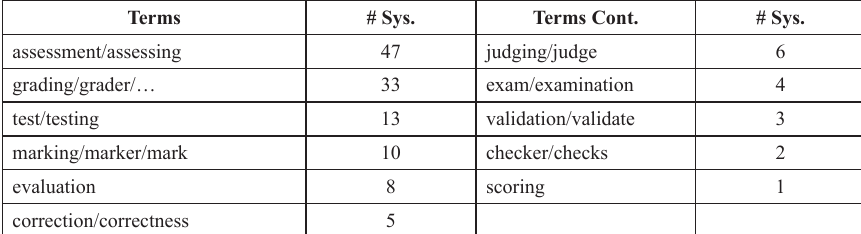
Table 3. Overview of used variations of assessment/grading/marking/etc. terms Terms # Sys. Terms Cont.